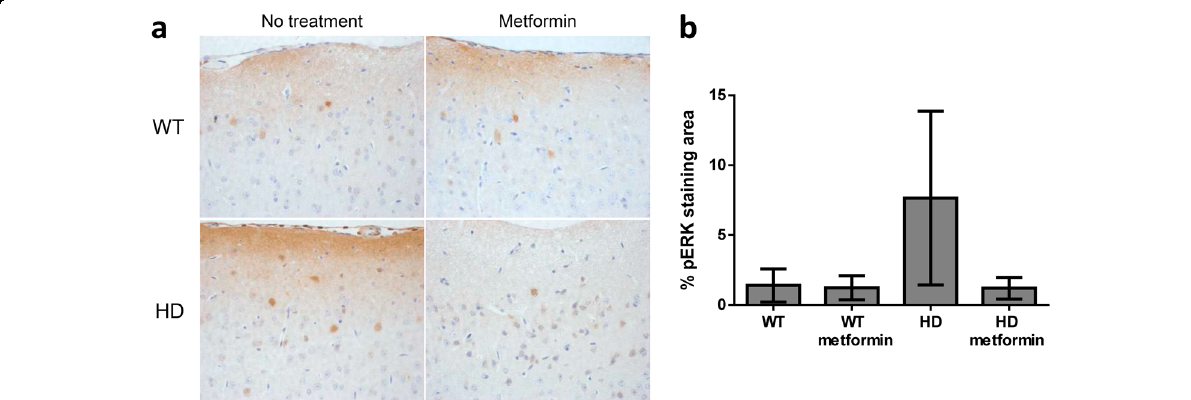
Fig. 8 Metformin treatment reduces phospho-extracellular signal-regulated kinase1/2 (pERK1/2) expression in Huntington disease (HD) mice. a Immunohistochemical (IHC) staining of the cortex of Huntington disease (HD) and control mice using the anti-pERK1/2 antibody. Representative images of each condition are shown (bar: 50 µm). b Semiquantitative analysis of IHC staining using the ImageJ software. Samples from four independent mice from each group, except for HD-treated mice, of which we used six mice, were analyzed. These mice generated the following material: 12 cortex pictures from untreated wild-type (WT), 12 cortex pictures from treated wild-type (WT metformin), 12 cortex pictures from untreated zQ175 (HD), and 18 cortex pictures from HD treated (HD metformin) mice. The analyzed area in each picture was 90,488 μ m 2 . HD mice showed higher levels of pERK1/2 than WT mice ( p = 0.011). Treatment with metformin reduced pERK1/2 levels ( p = 0.013) to levels similar to those in WT mice ( p = 0.686). Values are the mean, and bars indicate the con fi dence interval (95%